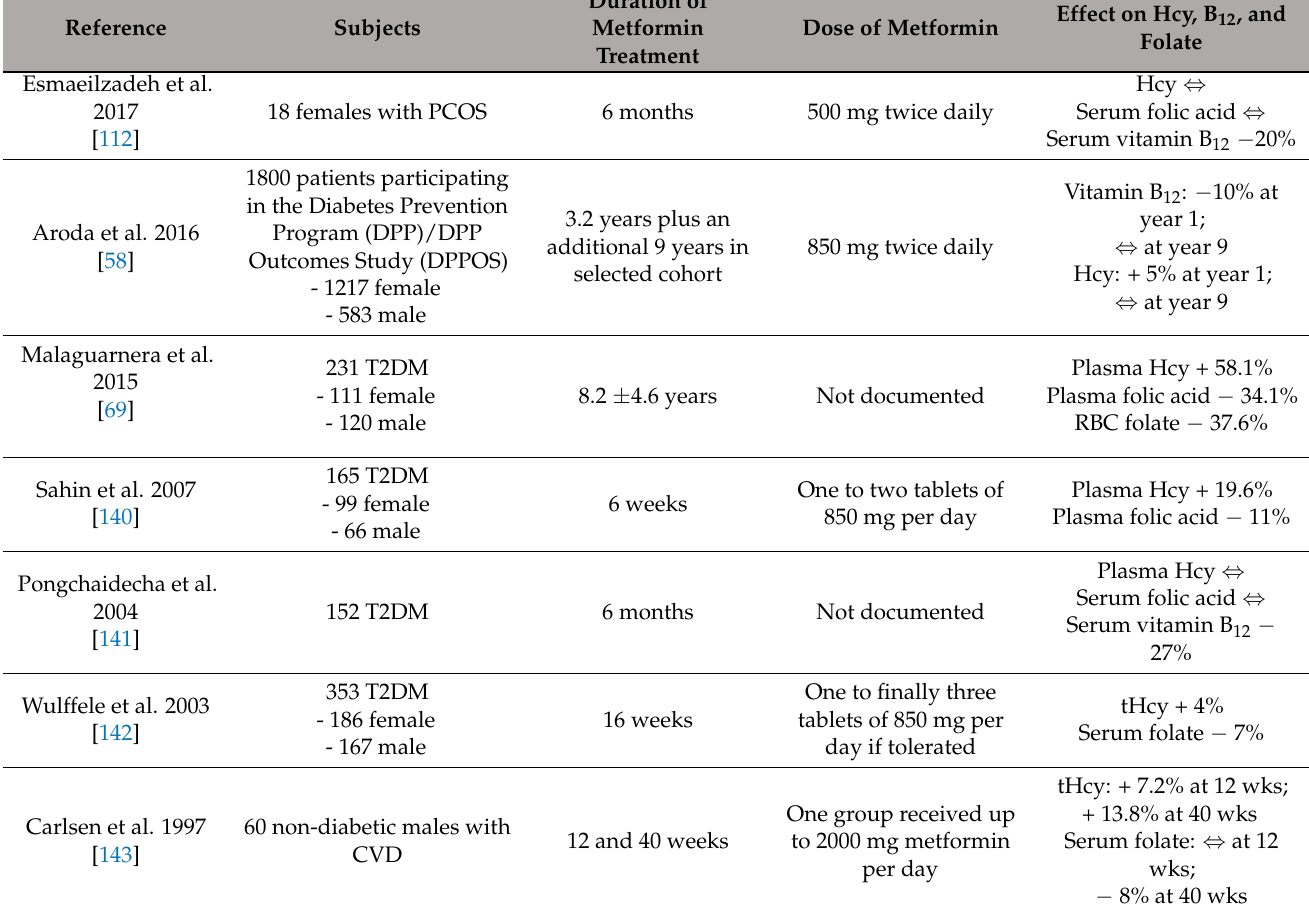
Table 4. Impact of metformin on folate, vitamin B 12 , and Hcy levels